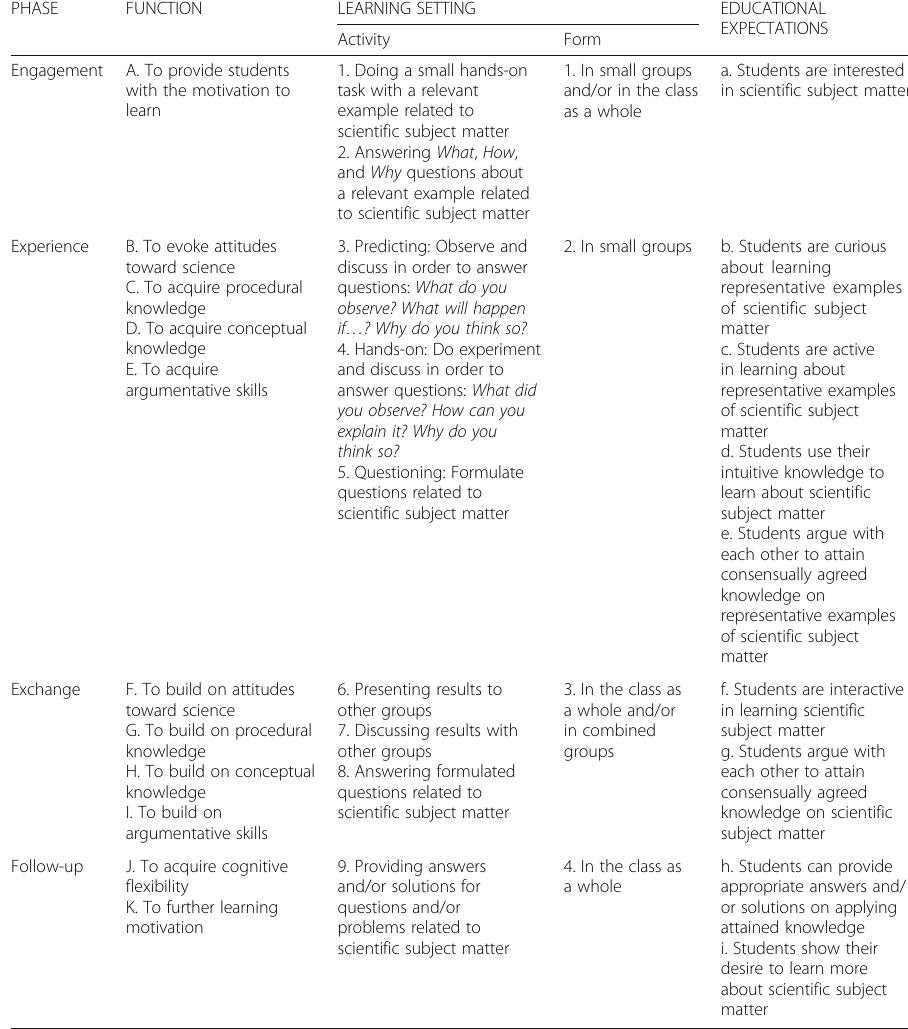
Table 6 The designed framework of the social constructivism-based curriculum for primary science education in a CHC PHASE FUNCTION Engagement A. To provide students with the motivation